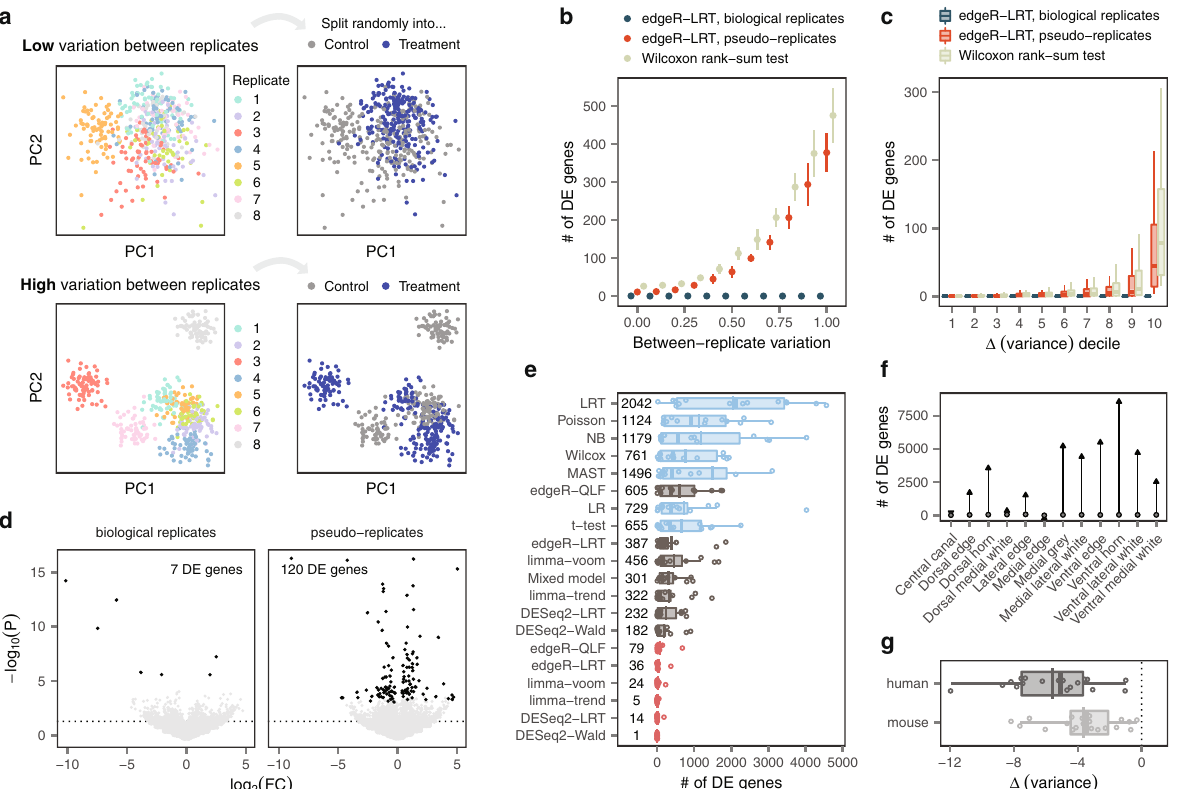
Fig. 4 False discoveries in single-cell DE. a Schematic illustration of simulation experiments. Single-cell RNA-seq datasets were simulated with varying degrees of heterogeneity between replicates. Replicates were then randomly assigned to either a ‘ treatment ’ or ‘ control ’ group, and DE analysis was performed between groups. b Number of DE genes detected in stimulation experiments with varying degrees of heterogeneity between replicates by a representative single-cell DE method, a representative pseudobulk method, and the same pseudobulk method applied to pseudo-replicates. Points and error bars show the mean and standard deviation across ten independent simulations. c Number of DE genes detected by the tests shown in b for genes divided into deciles by the magnitude of the change in variance between biological replicates and pseudo-replicates ( Δ -variance). d Volcano plots showing DE between T cells from random groups of unstimulated controls drawn from Kang et al. 5 using a representative pseudobulk method, edgeR-LRT, applied to biological replicates or pseudo-replicates. Discarding information about biological replicates leads to the appearance of false discoveries. e Number of DE genes detected in comparisons of random groups of unstimulated controls from 14 scRNA-seq studies with at least six control samples. f Number of DE genes detected within spinal cord regions from control mice pro fi led by spatial transcriptomics 24 using a representative pseudobulk method, edgeR-LRT (points), or a representative single-cell method, the Wilcoxon rank-sum test (arrowheads). g Mean change in variance between biological replicates and pseudo-replicates for 18 human and 20 mouse scRNA-seq